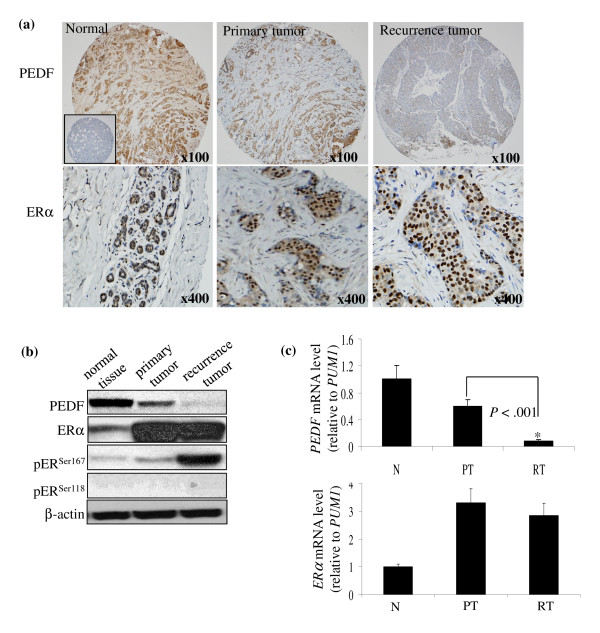
Pigment epithelium-derived factor expression in primary and recurrence breast tumor tissues. (a) Immunohistochemistry (IHC) staining for pigment epithelium-derived factor (PEDF) and estrogen receptor alpha (ERα) were performed on tissue microarrays generated from normal breast tissue (left panel), primary breast tumor tissue (n = 59; middle panel), and recurrence breast tumor tissue (n = 59; right panel). Cores used to generate tissue microarrays (TMAs) were 0.6 mm in diameter. Tumor tissues were also stained in the absence of a PEDF antibody to act as a negative control (left panel, inset). PEDF staining was quantified as an intensity score ranging from 0 to 255. A scale of 0 to 3 was used to score staining intensity of ERα. (b) Western blot analysis of normal tissue (N), primary breast tumor tissue (PT), or recurrence tumor tissue (RT) to assess PEDF, total ERα, and phosphorylated ERα (Ser118 and Ser167) protein level. β-actin was used as a loading control. (c) Representative quantitative real-time PCR analysis of PEDF and ERα mRNA expression in N, PT, or RT. For experiment, total RNA was extracted from paraffin-embedded tissues using Trizol and analyzed by real-time PCR as described in Materials and methods. PEDF and ERα mRNA were normalized to the internal control gene PUM1. All experiments were performed in triplicate. PEDF mRNA level was statistically significantly lower in the recurrence tumor tissue compared with the primary tumor tissue. *P < 0.001.